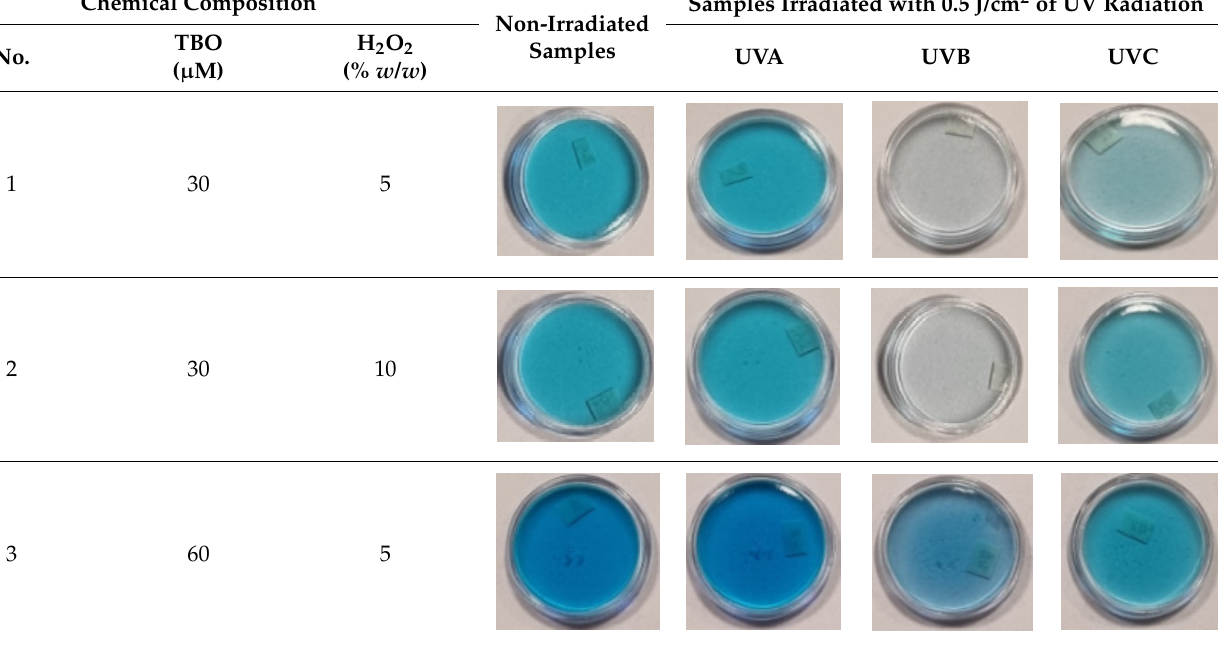
Table 1. Effect of TBO and H 2 O 2 concentrations in TBO–Pluronic F–127 hydrogels on their UV dose–response.